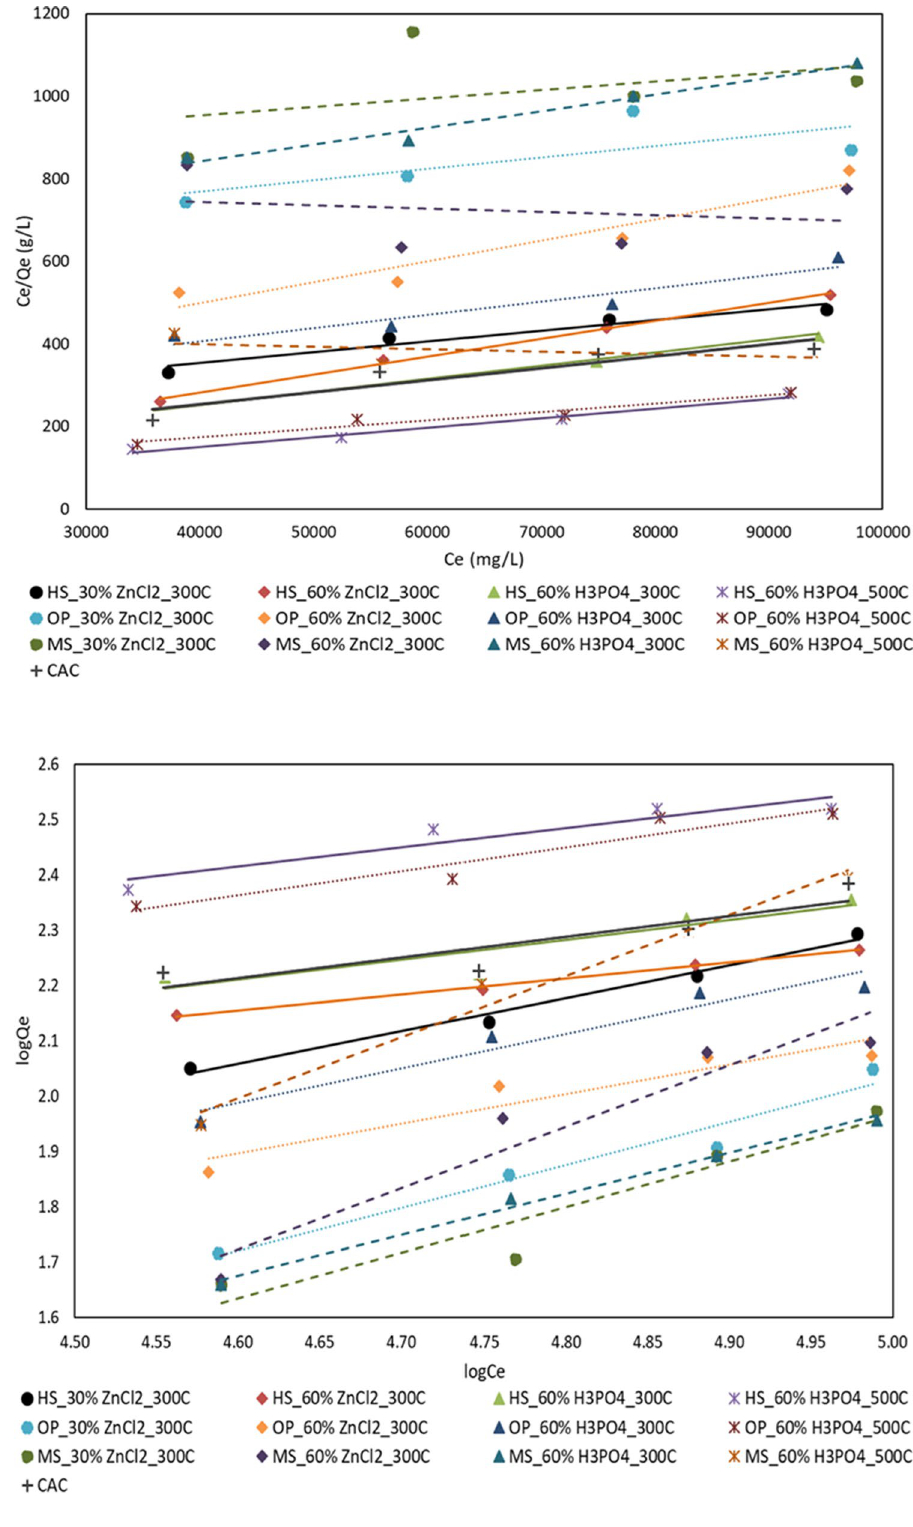
Fig. 3 Langmuir isotherms of acetic acid adsorptions onto three activated carbons after four different activation processes